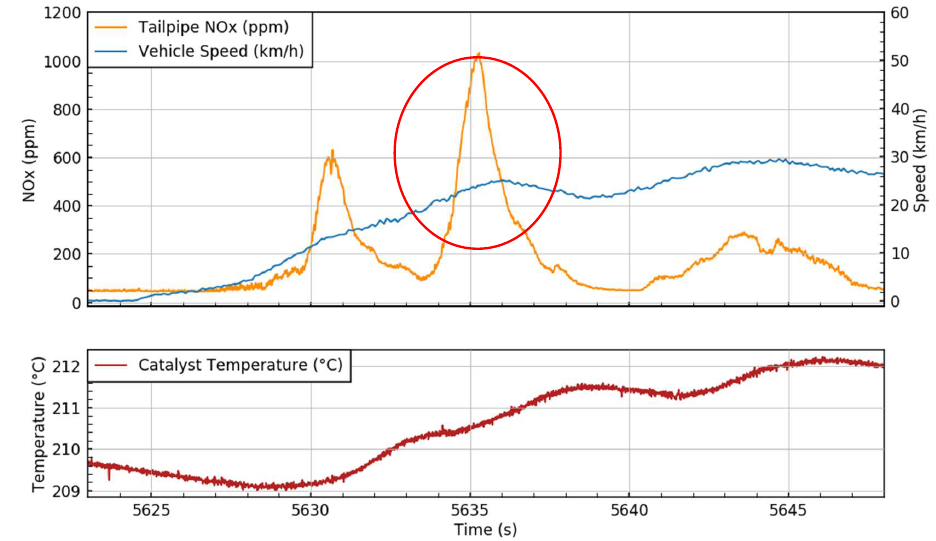
Figure 11. NO x emission from the Euro VI bus, showing the large spike (circled in red) associated with the gear change from third to fourth gear.